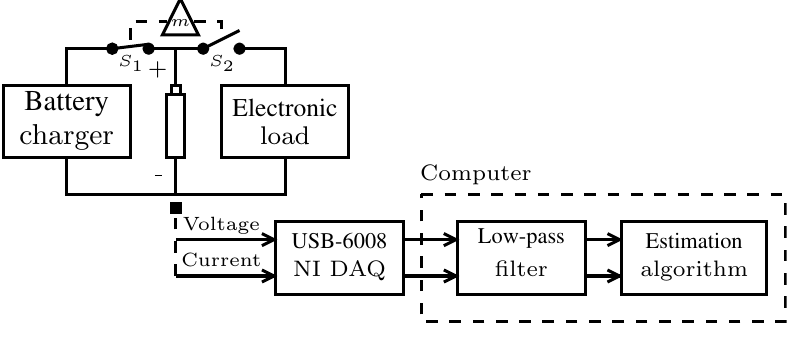
Figure 2. Illustration of the experimental